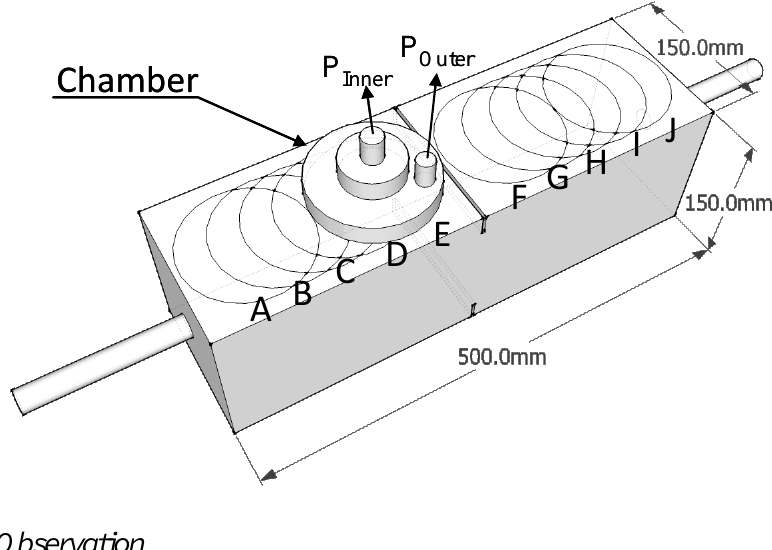
Figure 6. Measurement points in the air permeability test.